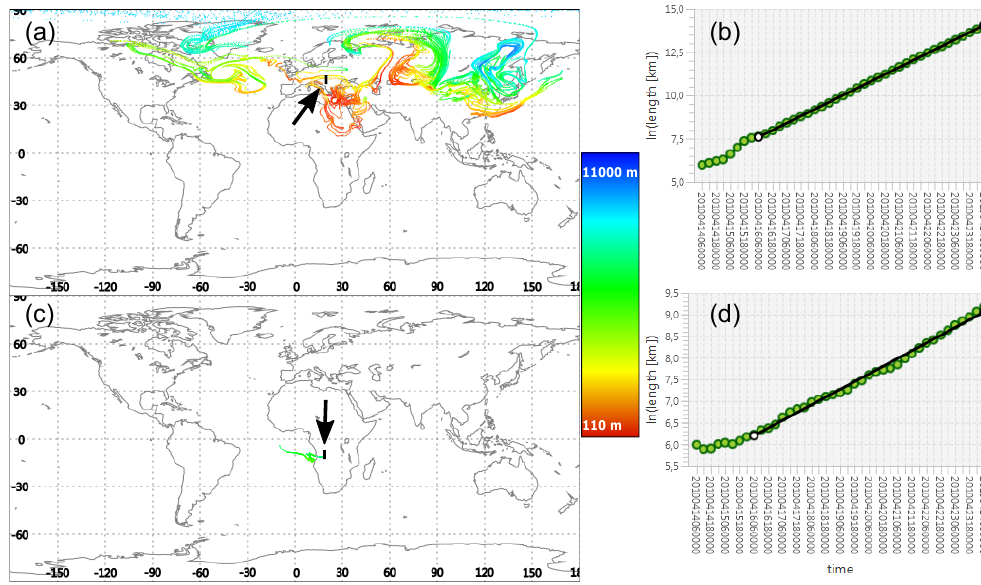
Figure 2. ( a , c ) The advection pattern of a pollutant cloud after 10 days, and ( b , d ) the time dependence of the logarithm of the length of the pollutant clouds, respectively. The simulations are initialized with the simulation parameters on the left of Figure A1 but with top and bottom reflection coefficients of 1 and inserting new particles if the distance of two particles became greater than 100 km. The pollutant clouds are initialized as meridional line segments of 400 km at the altitude of 5500 m at ( a , b ) 47 ◦ N, 19 ◦ E and ( c , d ) 10 ◦ S, 19 ◦ E. They consist of 1000 particles at the beginning. Their initial position is indicated by the thick black lines to which arrows are pointing. The particle radius is 0 µ m. Colorbar indicates the altitude of the particles. In panel ( b , d ) the black line indicates a linear fit to the logarithm of the length for the time interval from 16 April, 6 UTC to 24 April, 6 UTC. Its slope is ( b ) h = 0.808 day − 1 and ( d ) h = 0.357 day − 1